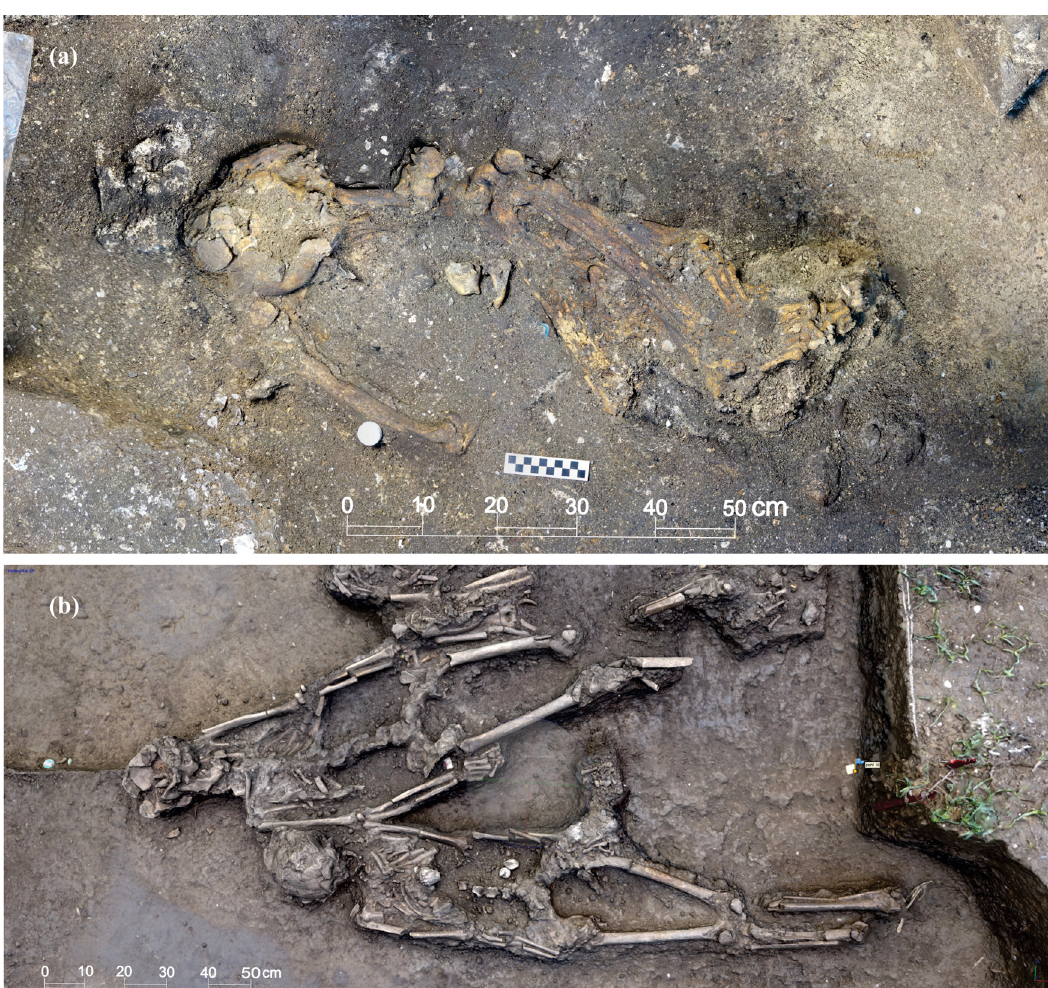
Figure 8: Details of the 3D reconstruction of burials from Canímar Abajo ( a ) and Playa del Mango ( b ) for subsequent archae - othanatological studies.